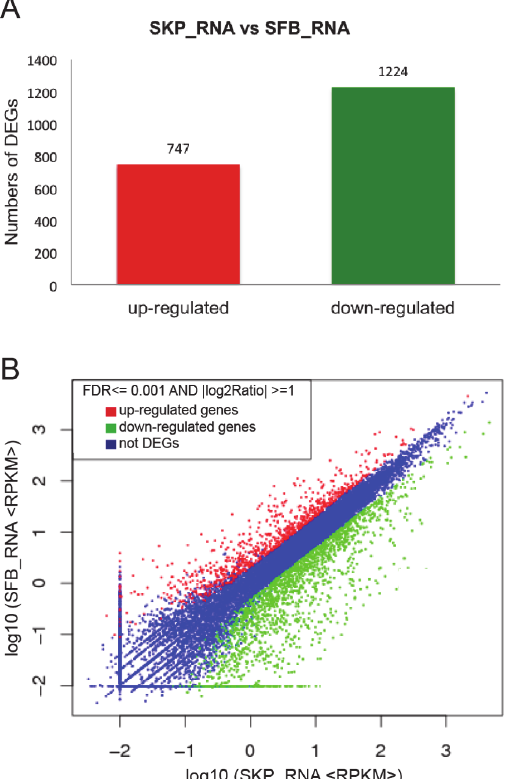
Fig 4. DEGs between SKPs and SFBs. (A) The numbers of DEGs.(B) Scattered plot of